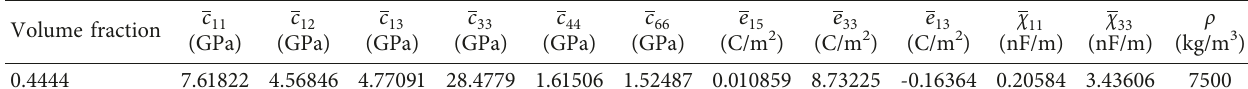
Table 4: The material properties of the bilayered PCMs actuator were calculated by AHM.